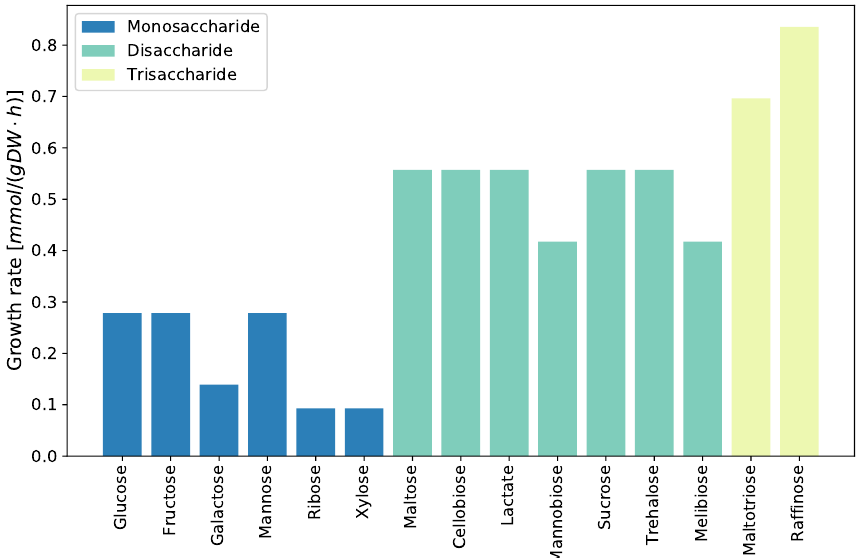
Figure 4. Growth on different carbon sources. D. pigrum ’s ability to utilize different carbon sources was investigated using the previously defined minimal medium. The available mono-, di-, and trisaccharides were examined concerning the resulting growth rate. As expected, trisaccharides result in a higher growth rate compared to di- and